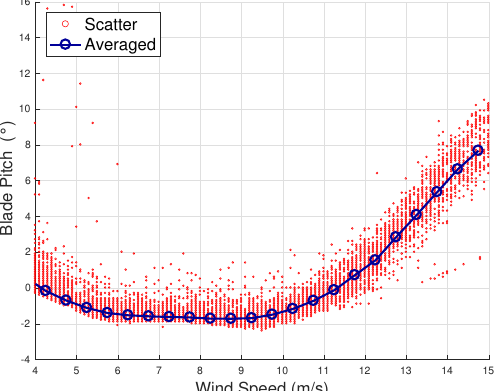
Figure 4. A sample scatter and binned wind speed–blade pitch curve for WF2. Table 2. Wind turbine operation regions considered in this work.